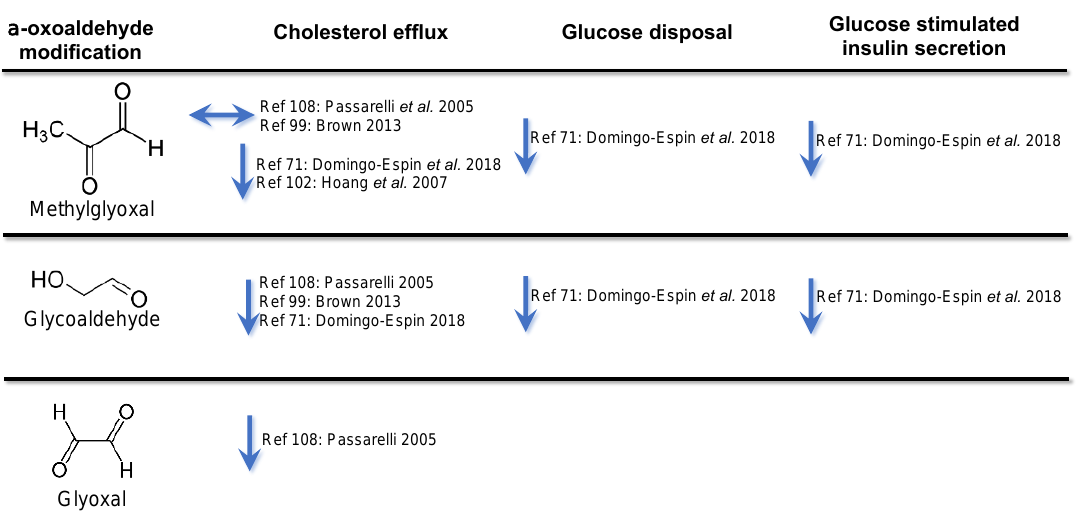
Figure 1. Nonenzymatic glycation of apoA-I impairs HDL function. ApoA-I that has been nonenzymatically glycated glycated by the reactive α -oxoaldehydes, glycoaldehyde and glyoxal, has an impaired ability accept cholesterol from cells. Nonenzy- matic glycation of apoA-I with the reactive α -oxoaldehyde, methylglyoxal, has variable effects on cholesterol efflux. Nonenzymatic glycation impairs the ability of apoA-I to mediate glucose disposal in skeletal muscle and increase insulin secretion in response to glucose in β